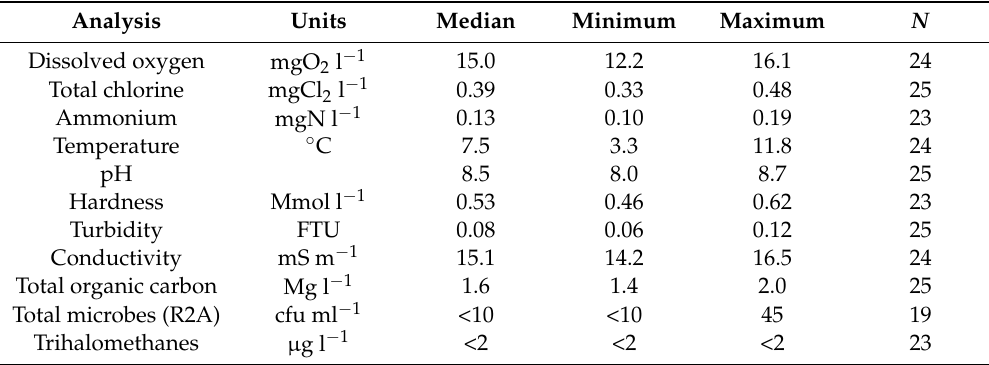
Table 1. The quality of the drinking water at the Pitkäkoski water treatment plant (WTP) from 2010 to 2015. The analyses are from the analytically extensive monitoring which was organized 4–6 times a year by Helsinki Region Environmental Services Authority (HSY) [20].